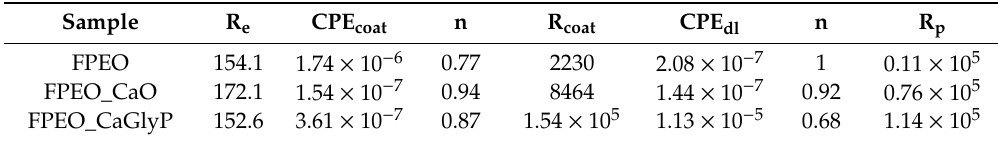
Table 8. Fitted parameters of the EIS data for the PEO coatings after 24 h of immersion in 0.5 %